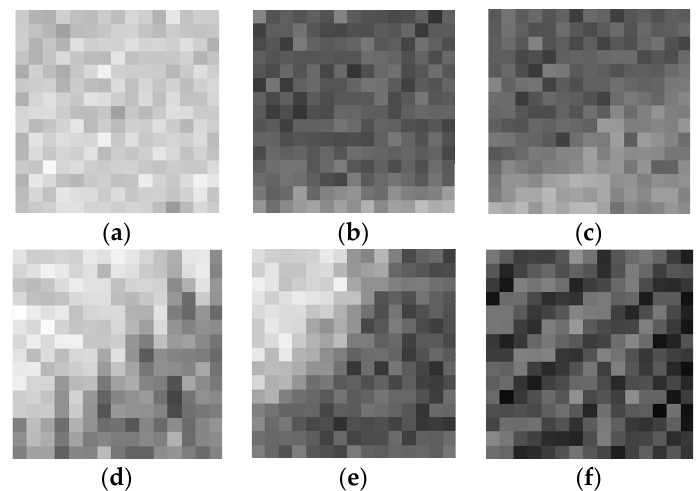
( f ) H of noisy image blocks corrupted by additive white Figure 3. Local gray statistic entropy Figure 3. Local gray statistic entropy H le of noisy image blocks corrupted by additive white Gaussian le σ = , and weakly textured blocks have bigger LGSE noise (AWGN) at noise level σ n = 20, and weakly textured blocks have bigger LGSE values; Gaussian noise (AWGN) at noise level 20 n ( a ) H le = 7.8094; ( b ) H le = 7.7155; ( c ) H le = 7.6537; ( d ) H le = 7.4976; ( e ) H le = 7.3127; ( f ) H le = H = 7.8094; ( b ) H = 7.7155; ( c ) H = 7.6537; ( d ) H = 7.4976; ( e ) H = 7.3127; ( f ) values; ( a ) le le le le le H = 7.1362. le